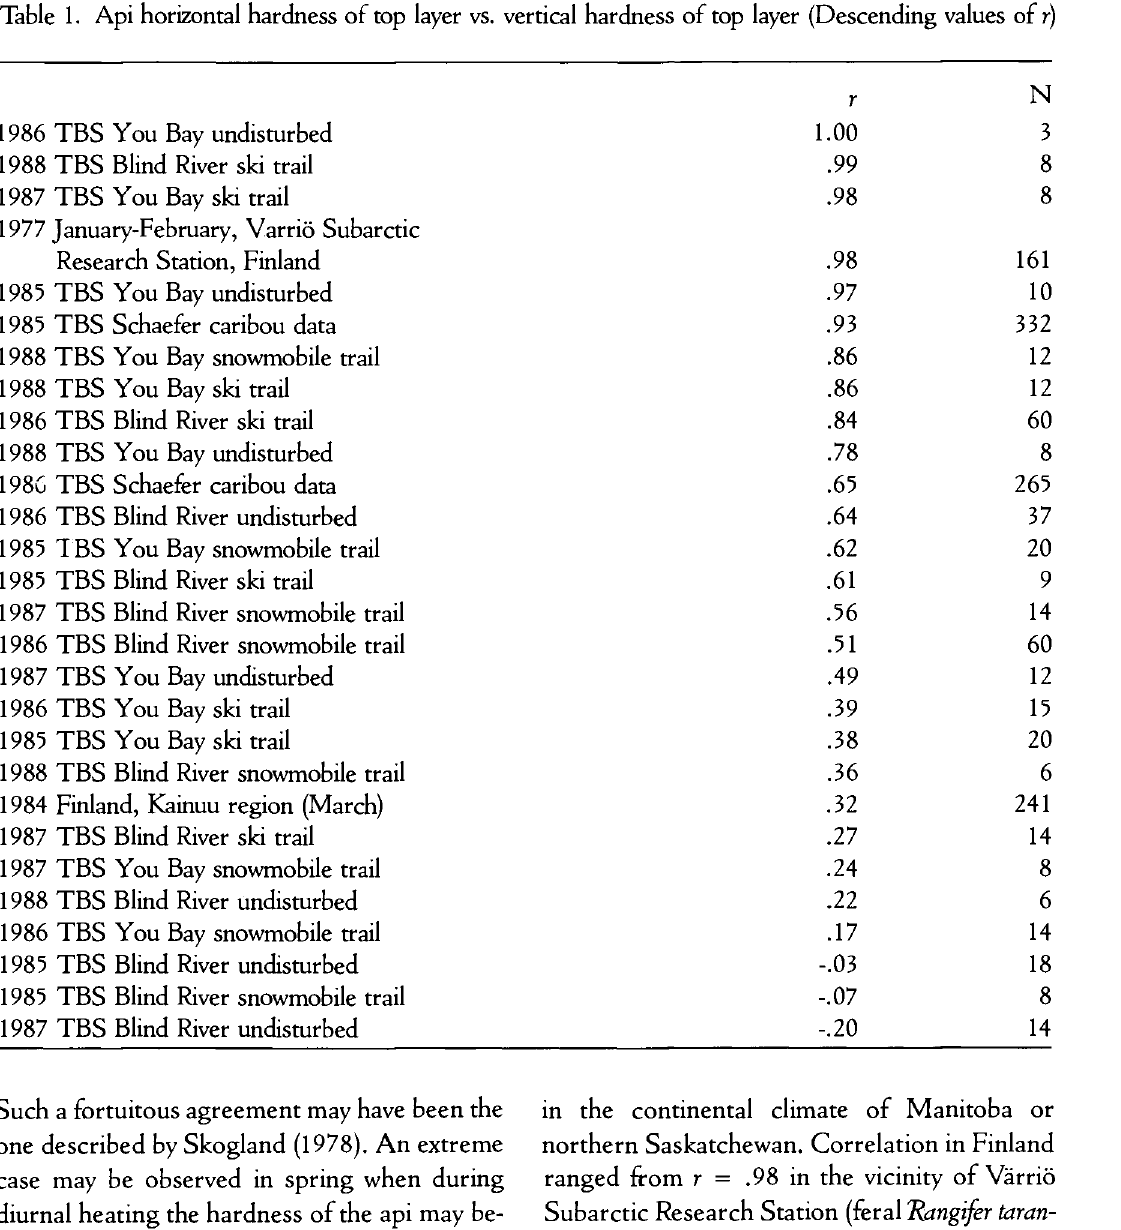
Table 1. Api horizontal hardness of top layer vs. vertical hardness of top layer (Descending values of r) 1986 TBS You Bay undisturbed 1.00